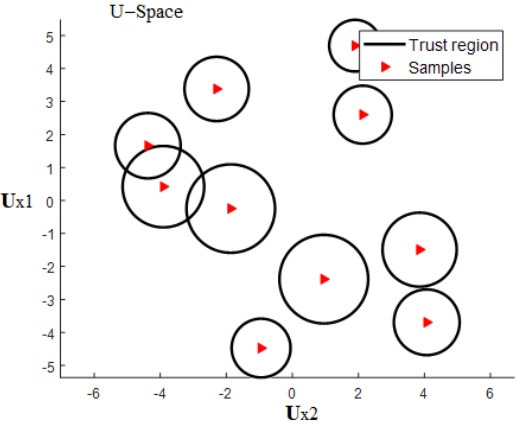
Figure 2. The 90% trust regions of different training samples. Ignoring the level of prediction error of different samples may lead to a concentration of training samples in the local nonlinear region, which further leads to a reduction in the ef- ficiency of model construction [32]. Therefore, based on the authors’ previous research [40], a sample distribution balancing approach is introduced to form the distribution-based sampling strategy. The mathematical expression of the improved learning function LF’ proposed in this paper is as follows: